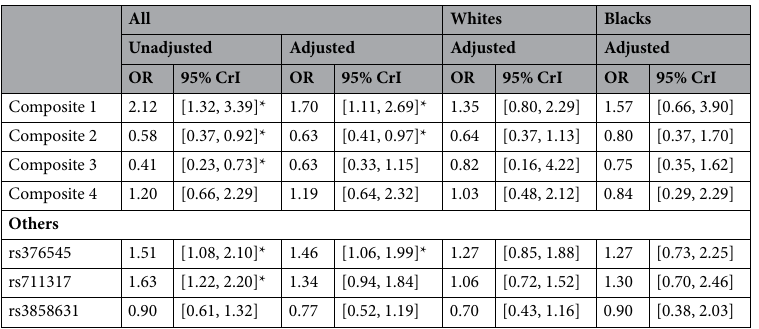
Table 2. Estimates of the effect (odds ratio) of each correlated group on AD disease persistence and corresponding posterior intervals. OR greater than 1 indicate less disease persistence. Composite variables are based on presence of at least one SNP in each correlated group: Group 1 = [rs177079, rs298118, rs298121, rs298122, rs1054122]. Group 2 = [rs1063931, rs3907935, rs4761912, rs4761913, rs12578949, rs12581781, rs17845411, rs3858630]. Group 3 = [rs11540301, rs12581120, rs61510718, rs62617088]. Group 4 = [rs188463, rs188464, rs298117, rs298119, rs298120, rs1053854, rs1053857, rs28667515, rs1133153]. *Credible interval (CrI) is either completely above or below